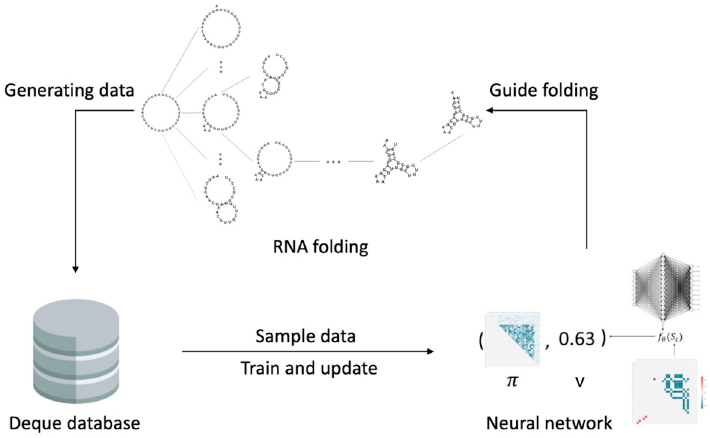
Figure 2. Diagram of the learning process of RNA molecular secondary structure folding path.